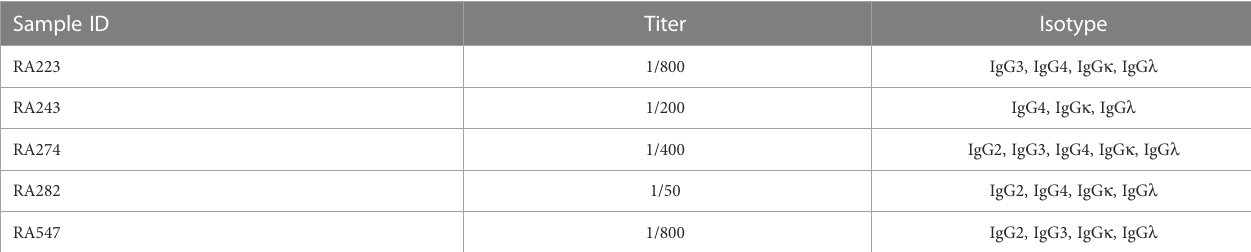
TABLE 3 Titer and isotype of the autoanti-FB IgG